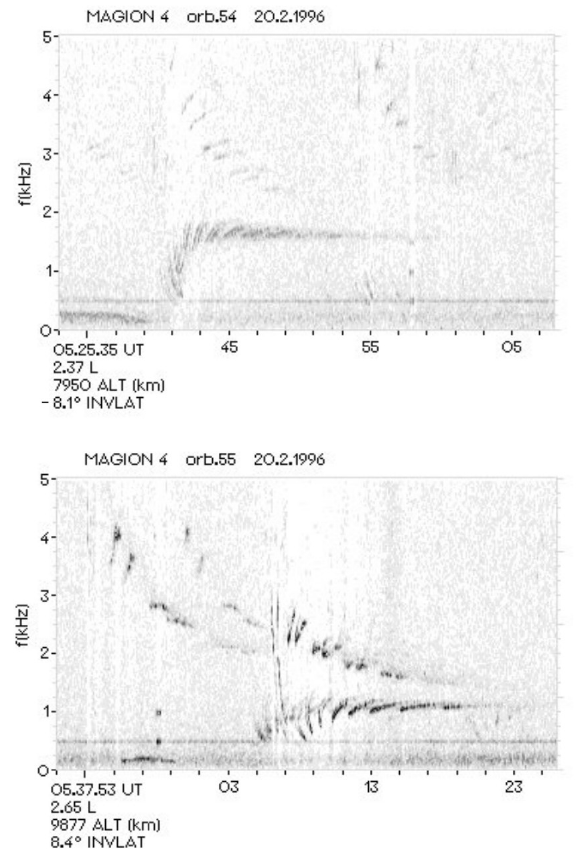
Fig. 3. Examples of more complicated types of MR whistlers recorded on the same orbit of MAGION 4, where the MR whist- ler shown in the upper left panel of Fig. 2 has been received.